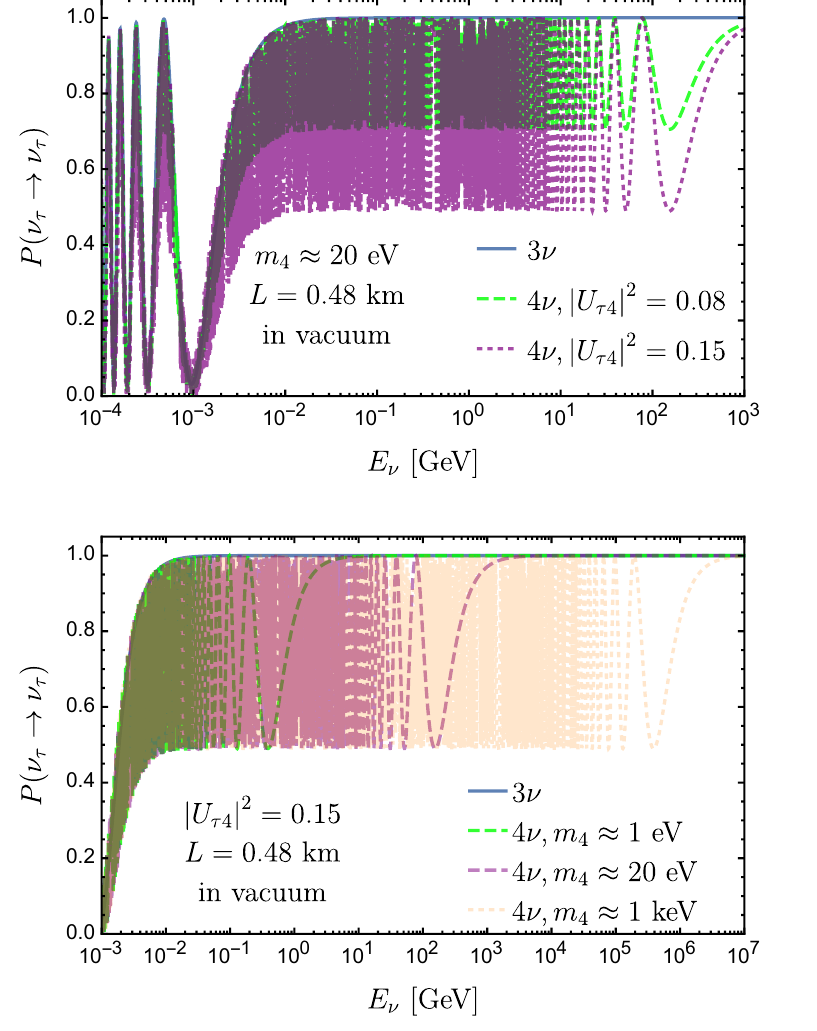
Figure 12 . The survival probability P ( (cid:23) (cid:28) ! (cid:23) (cid:28) ) as a function of the tau neutrino energy E (cid:23) , for the standard 3-active-(cid:13)avor oscillation framework [1] and in a 3+1 oscillation scenario, considering a baseline of L = 480 m. Besides results in the standard framework, the upper panel shows results for the 3+1 scenario with m 4 = 20 eV, for j U (cid:28) 4 j 2 = 0 : 08 and 0.15, whereas the lower panel shows results for the 3+1 scenario with j U (cid:28) 4 j 2 = 0 : 15 and m 4 = 1 eV, 20 eV and 1